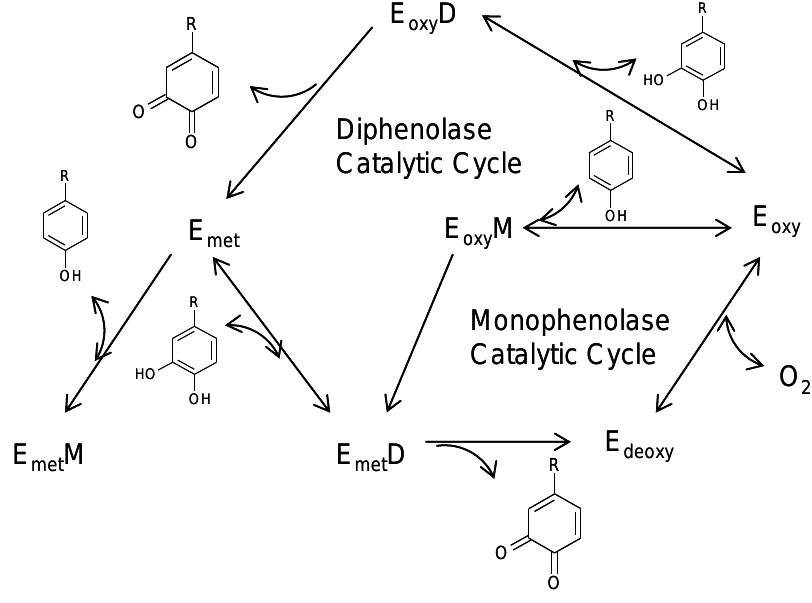
Figure 2. Catalytic cycles of the hydroxylation of monophenol and oxidation of o-diphenol to o -quinone by tyrosinase [23-24]. E respectively. E Monophenol complexes,